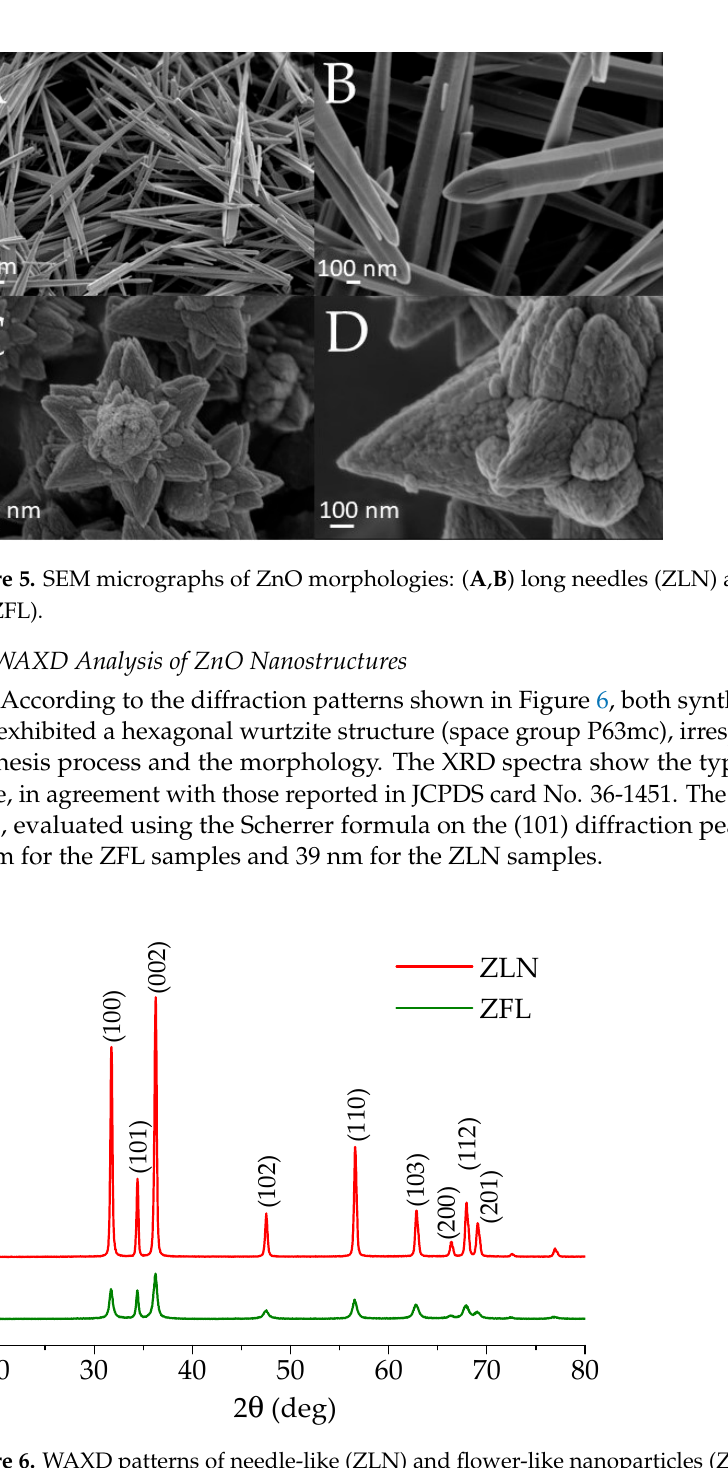
Figure 6. WAXD patterns of needle-like (ZLN) and flower-like nanoparticles (ZFL).